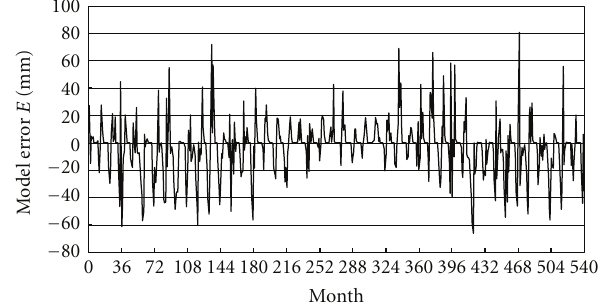
Figure 7: Model error E calculated by subtracting the monthly total rainfall data from the calculated values. The data represent that obtained from the weather station of Kuwait Airport for the time duration from January 1965 (corresponding to month number 0) to December 2009 (month number